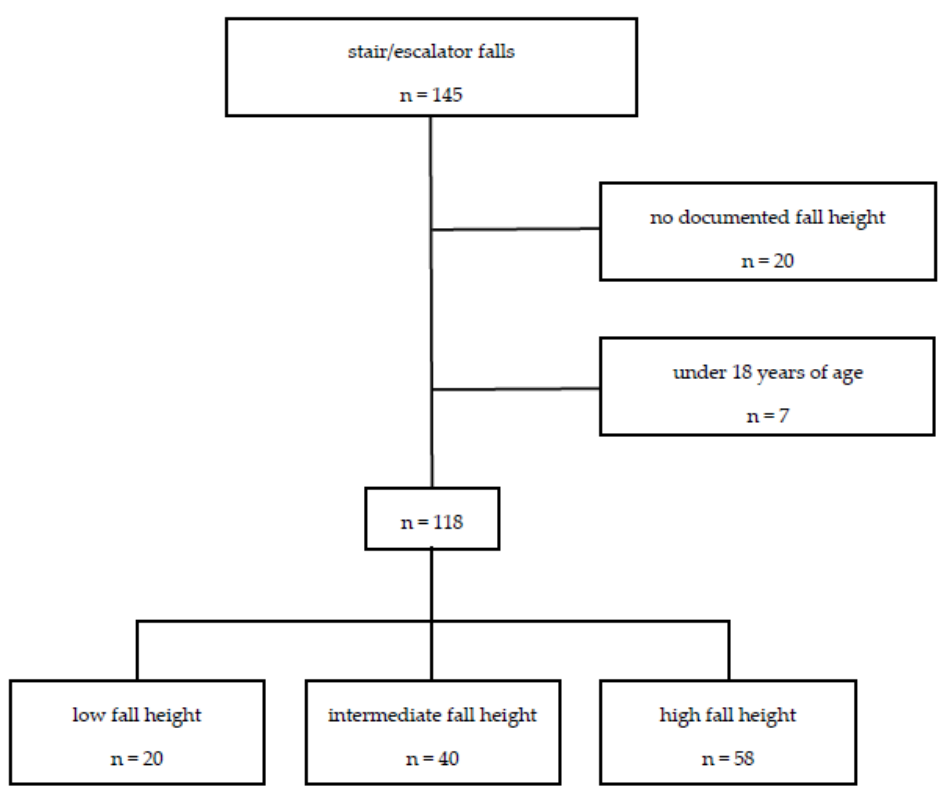
Figure 1. Patients were categorized into three groups based on documented fall height. Fall victims without documented fall height as well as patients under the age of 18 were excluded.